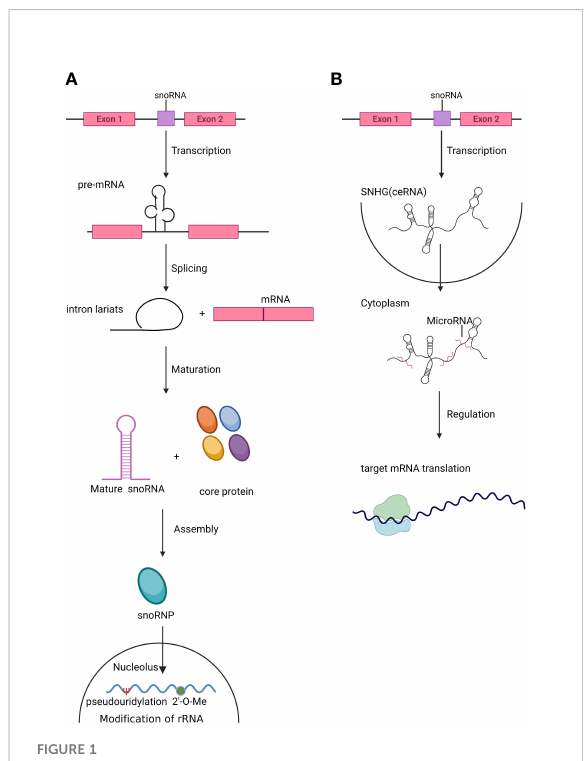
FIGURE 1 The biogenesis of snoRNAs and SNHGs. (A). Small nucleolar RNAs (snoRNAs) are mainly located in introns. After splicing and maturation, mature snoRNAs are exported to the nucleolus, where they assist in the modi fi cation and processing of rRNA and snRNA. (B). Small nucleolar RNA host genes (SNHGs) are transcribed and act as competing endogenous RNAs (ceRNAs) by antagonizing miRNAs and modulating the translation of target